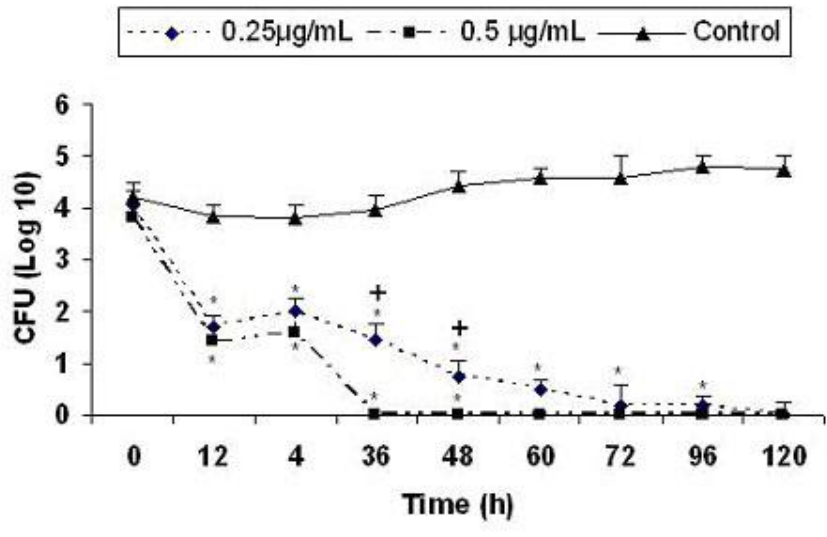
Figure 2. Time-kill plots showing the P. brasiliensis growth in cultures without or with 0.25 μ g/mL and 0.5 μ g/mL of amphotericin B. Results are representative of five independent experiments. * (p < 0.05) versus control; + (p < 0.05) versus 0.5 µg/mL